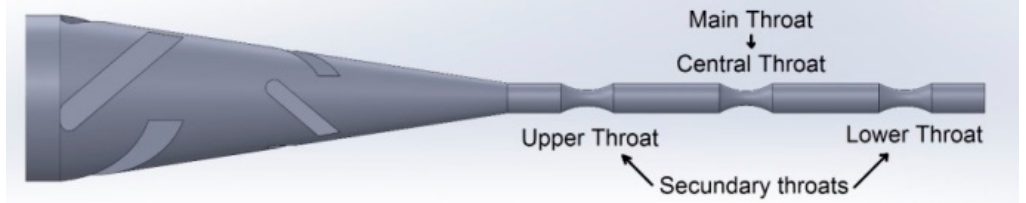
Figure 14. Horn and specimen for tension/torsion biaxial testing [15].